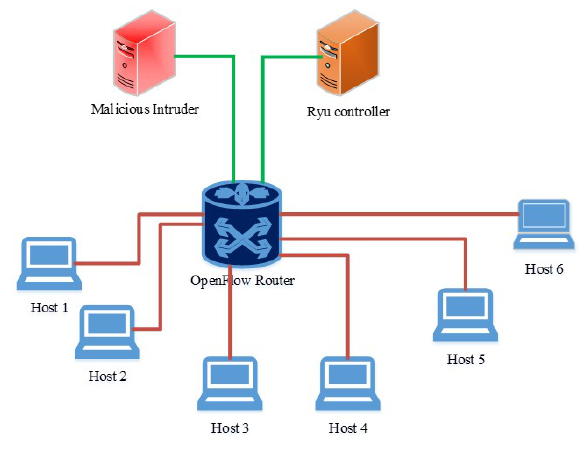
Figure 6. Experimental topology.